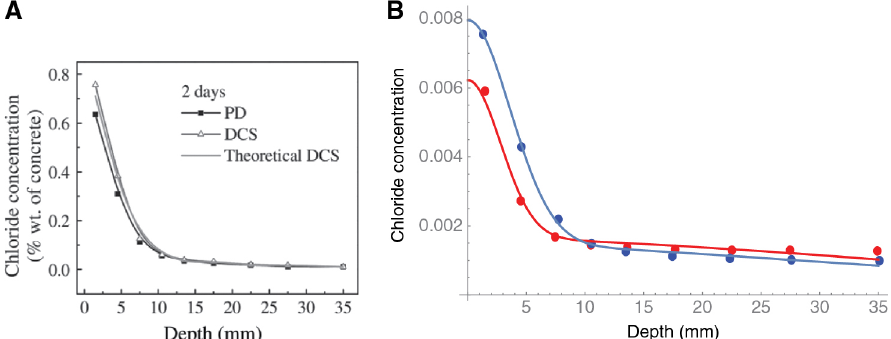
Figure 5: (A) Chloride concentrations of pure concrete as a function of depth under pure diffusion (PD) and diffusion coupled scouring (DCS). (B) Comparison between theoretical predictions and simulation results [23].